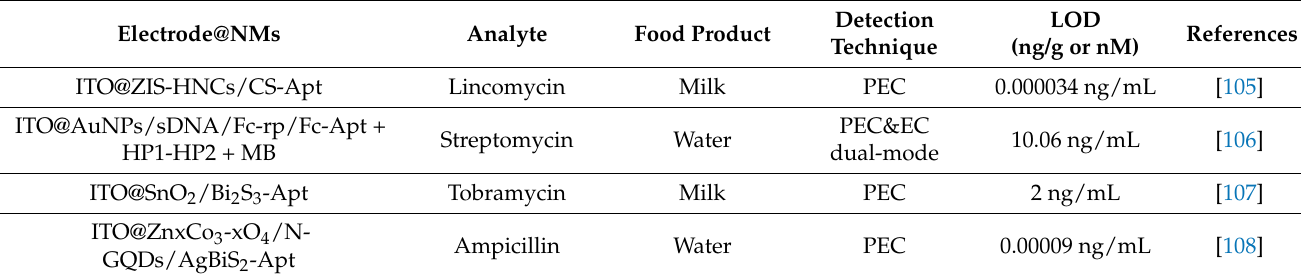
Table 3. Electrochemical derived techniques for the aptasensing of antimicrobial residues in food